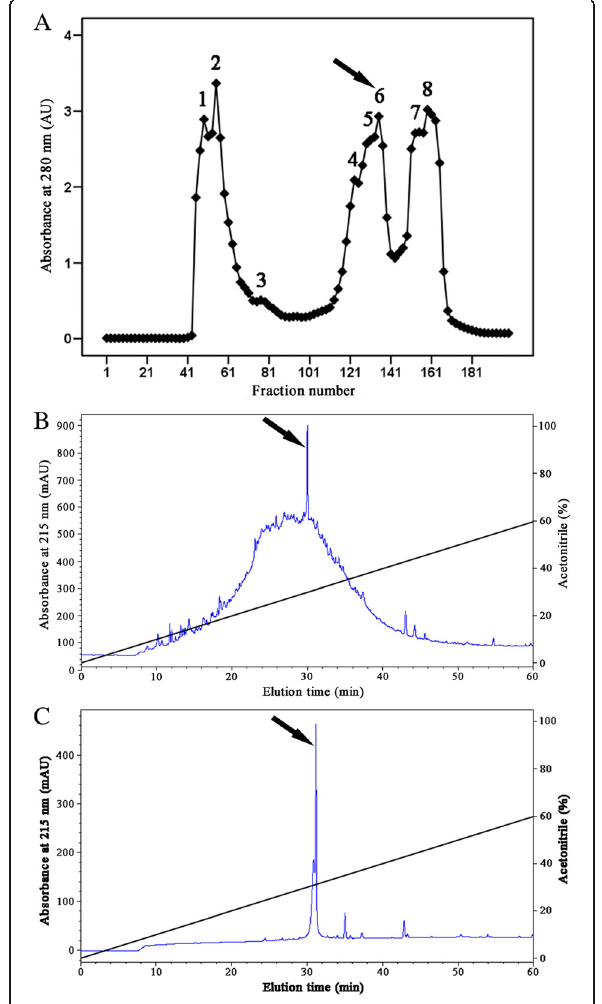
Fig. 1 Purification of Es-termicin from cockroach E. sinensis . a Gel filtration chromatography of E. sinensis sample on a Sephadex G-50 (superfine) column. The column (2.6 × 100 cm) was pre-equilibrated with Tris – HCl buffer (20 mM Tris – HCl, pH 7.6, containing 0.1 M NaCl) at a flow rate of 9 mL/h. Fractions were collected every 20 min. The absorbance of each tube was monitored at 280 nm. b Fraction 6 from ( b ) was pooled and applied on a C18 reverse-phase high performance liquid chromatography column (RP-HPLC, Hypersil BDS C18, 4.0 × 250 mm, Elite, China) equilibrated with 0.1 % (v/v) trifluoroacetic acid/water. The elution was performed with the indicated gradient of 0.1 % (v/v) trifluoroacetic acid/acetonitrile at a flow rate of 1 mL/min. c The fraction indicated by an arrow from ( b ) was further purified by the same RP-HPLC C18 column again. Fractions with antimicrobial activity are indicated by an